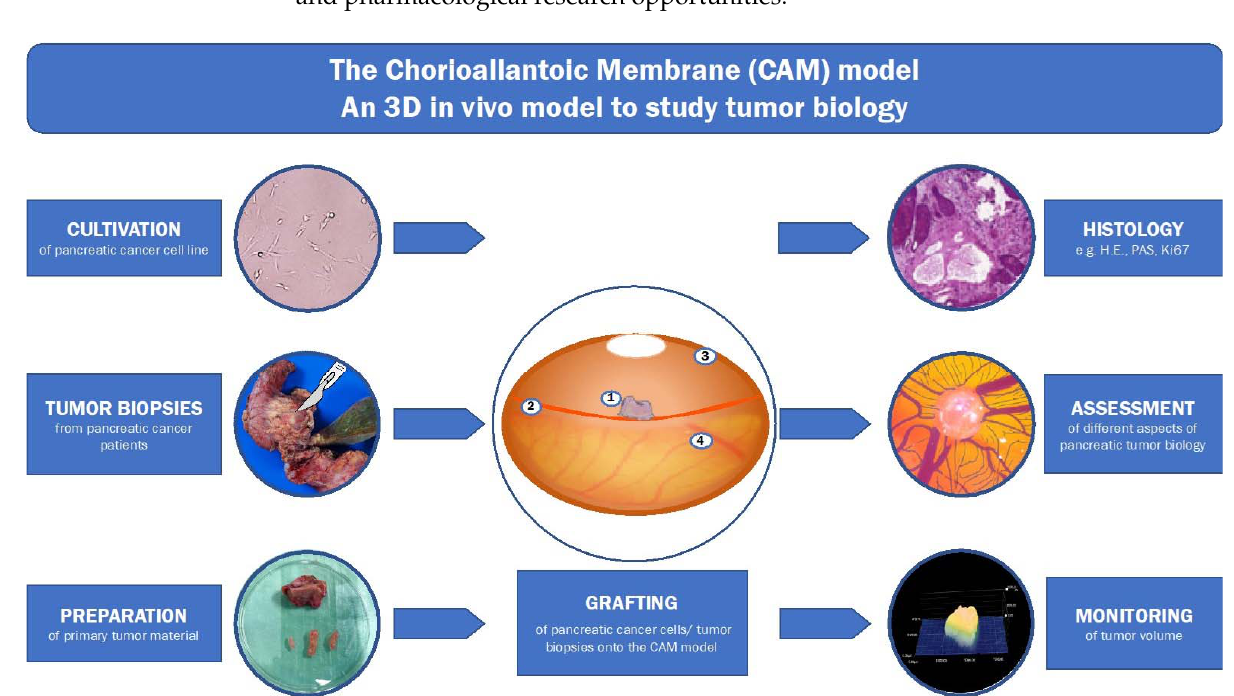
Figure 1. Illustration of the 3D in ‐ vivo model for the study of pancreatic ductal adenocarcinoma (1: tumor, 2: CAM ‐ vessels, 3: eggshell, 4: CAM). Cultivation of pancreatic cancer cell lines, as well as (1: tumor, 2: CAM-vessels, 3: eggshell, 4: CAM). Cultivation of pancreatic cancer cell lines,